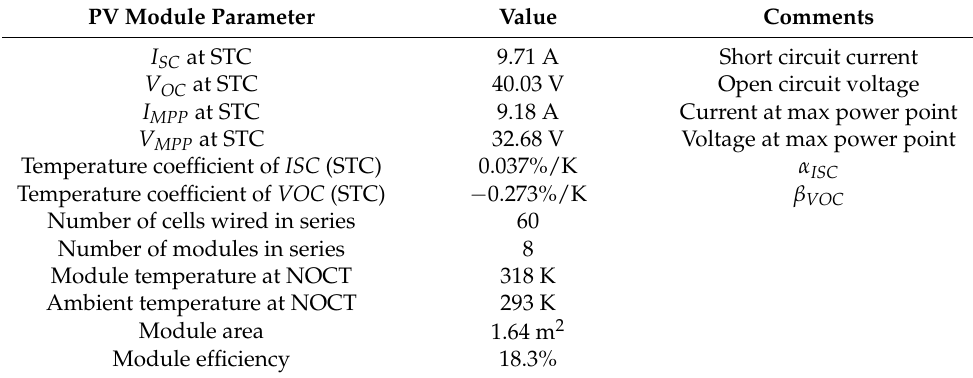
Table 4. Technical data of the monocrystalline silicon PV modules NUAC300B 300 Wp as used in type194